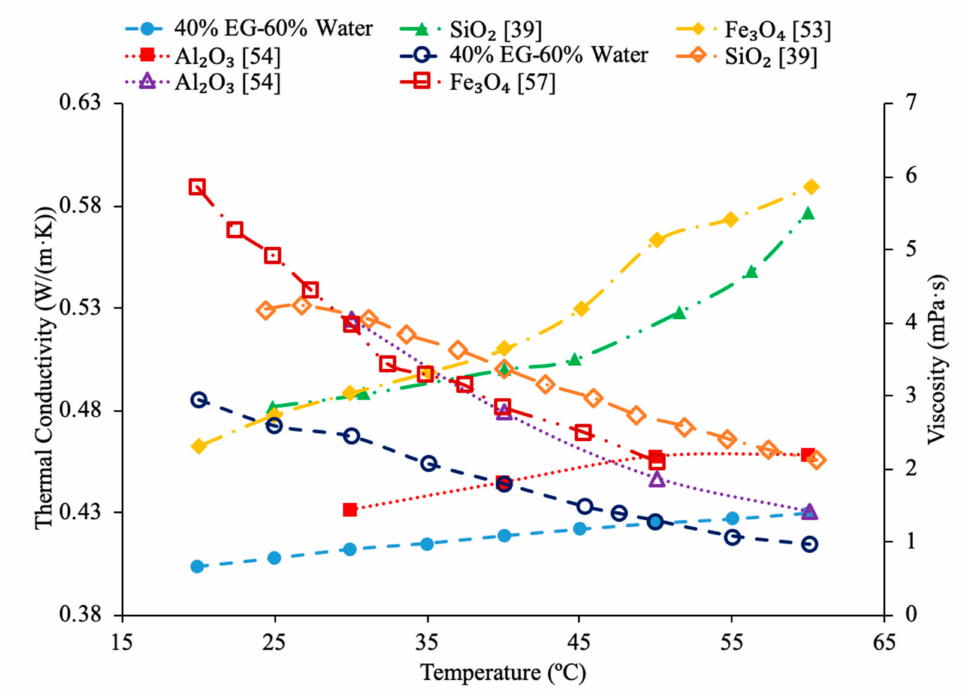
Figure 31. Thermal conductivity (increasing with temperature) and viscosity (decreasing with temper- ature) for SiO 2 , Fe 3 O 4 , and Al 2 O 3 40% ethylene glycol (EG)-60% water based nanofluids